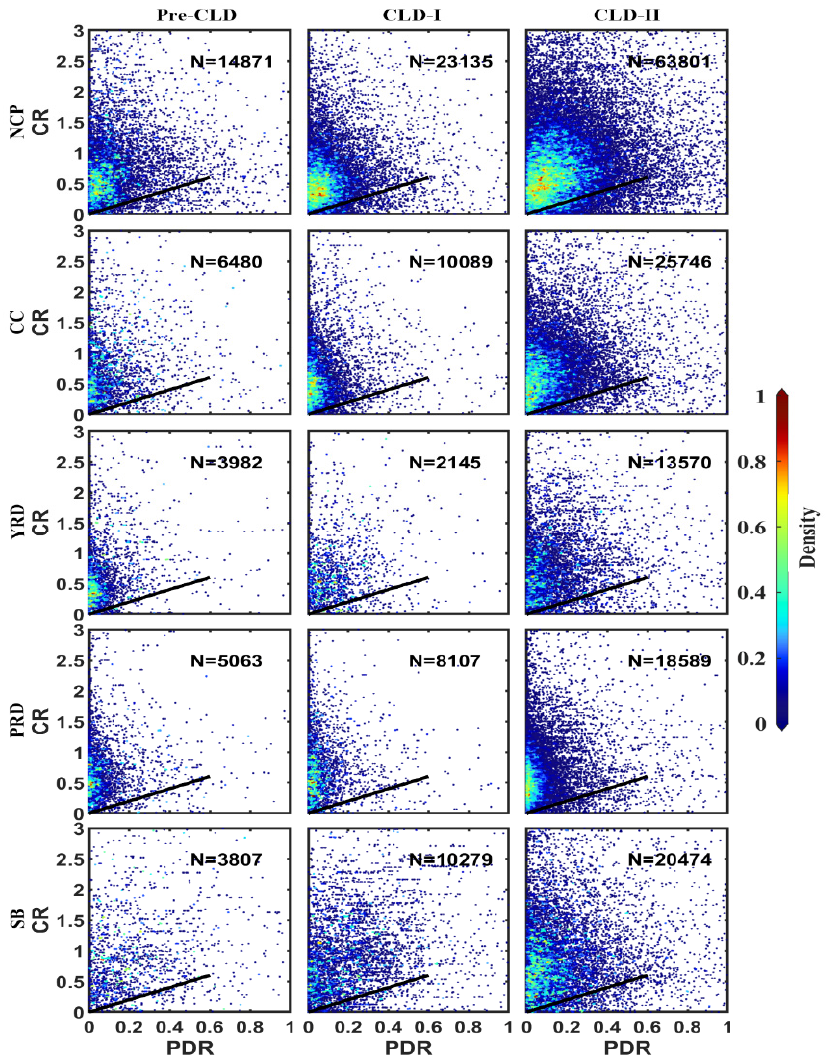
Figure 10. Scatterplots of PDR and CR in different lockdown stages in the five study areas, in which the black line represents the 1:1 line. The sample size (N) is also provided.